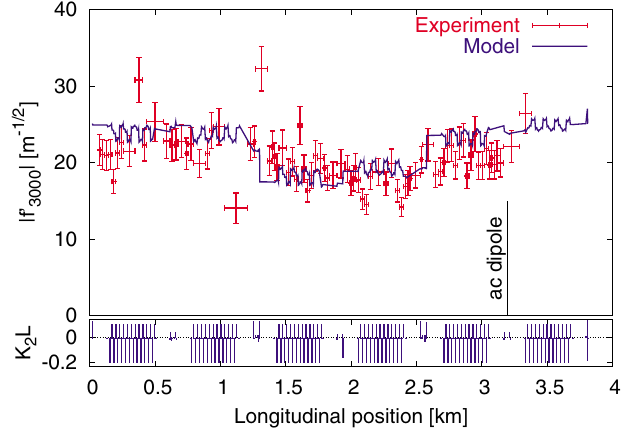
j with an ac dipole. The 3000